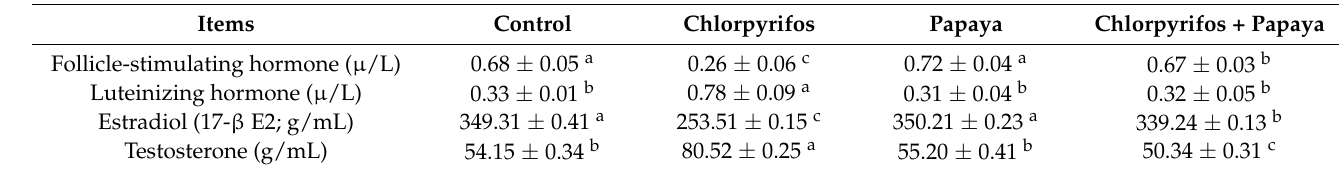
Figure 3. Total immunoglobulin ( A ) and lysozyme ( B ) of female African catfish, Clarias gariepinus , exposed to chlorpyrifos (8.75 µ g/L.) and co-administrated with papaya, Carica papaya aqueous extract (250 mg/kg body weight) for 6 weeks. The column bearing with different letters are significantly different ( p < 0.05). Table 3. Reproductive hormones in female African catfish, Clarias gariepinus , exposed to chlorpyrifos (8.75 µ g/L.) and/or co-administrated with papaya, Carica papaya , aqueous extract (250 mg/kg body weight) for 6 weeks.